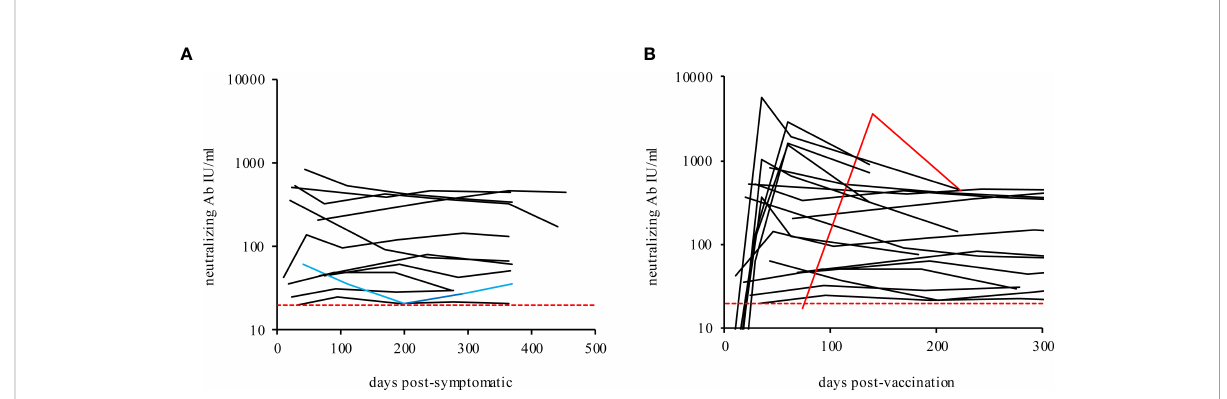
FIGURE 3 Neutralizing antibodies in recovered mild COVID-19 participants (A) and vaccinated participants (B) over time. The blue line shows the immune- suppressed participant 10. The red line shows participant 20 (post-COVID-19 and fully vaccinated with Comirnaty ® , BioNTech/P fi zer). The dashed lines indicate the TECO assay positive cut-off (20